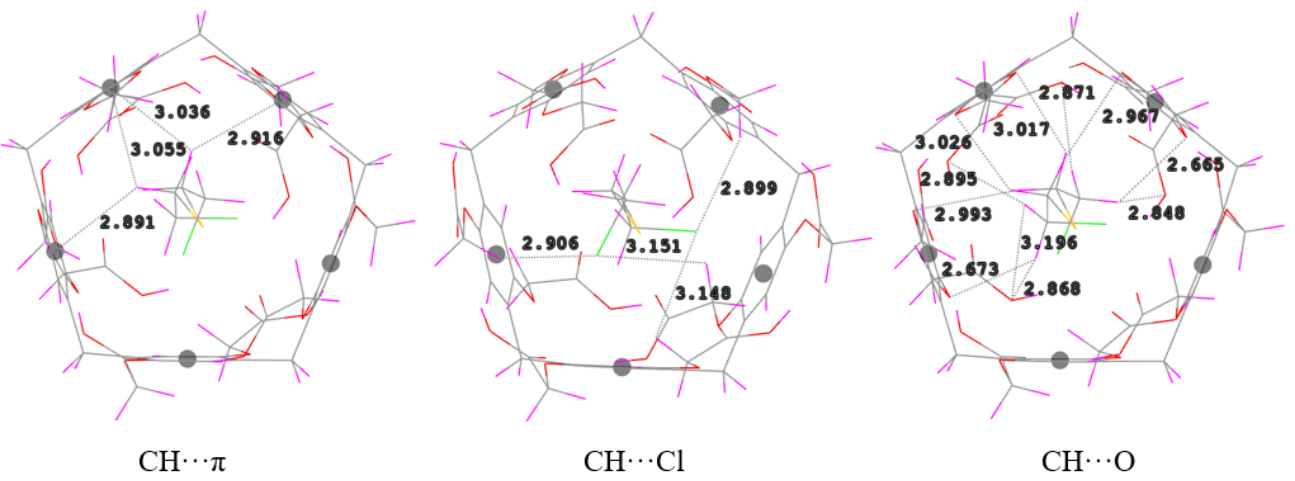
Figure 4. CH···π, CH···Cl and CH···O hydrogen bonding interactions in the complex SM@DCMP[5].